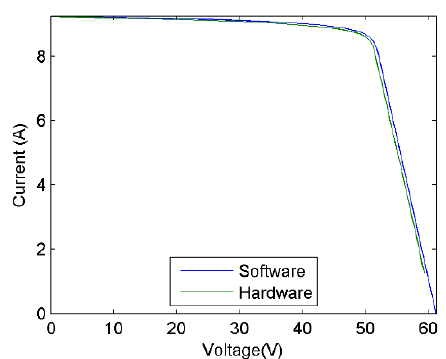
Figure 18. I-V curve of the photovoltaic panel emulator (PVPE).